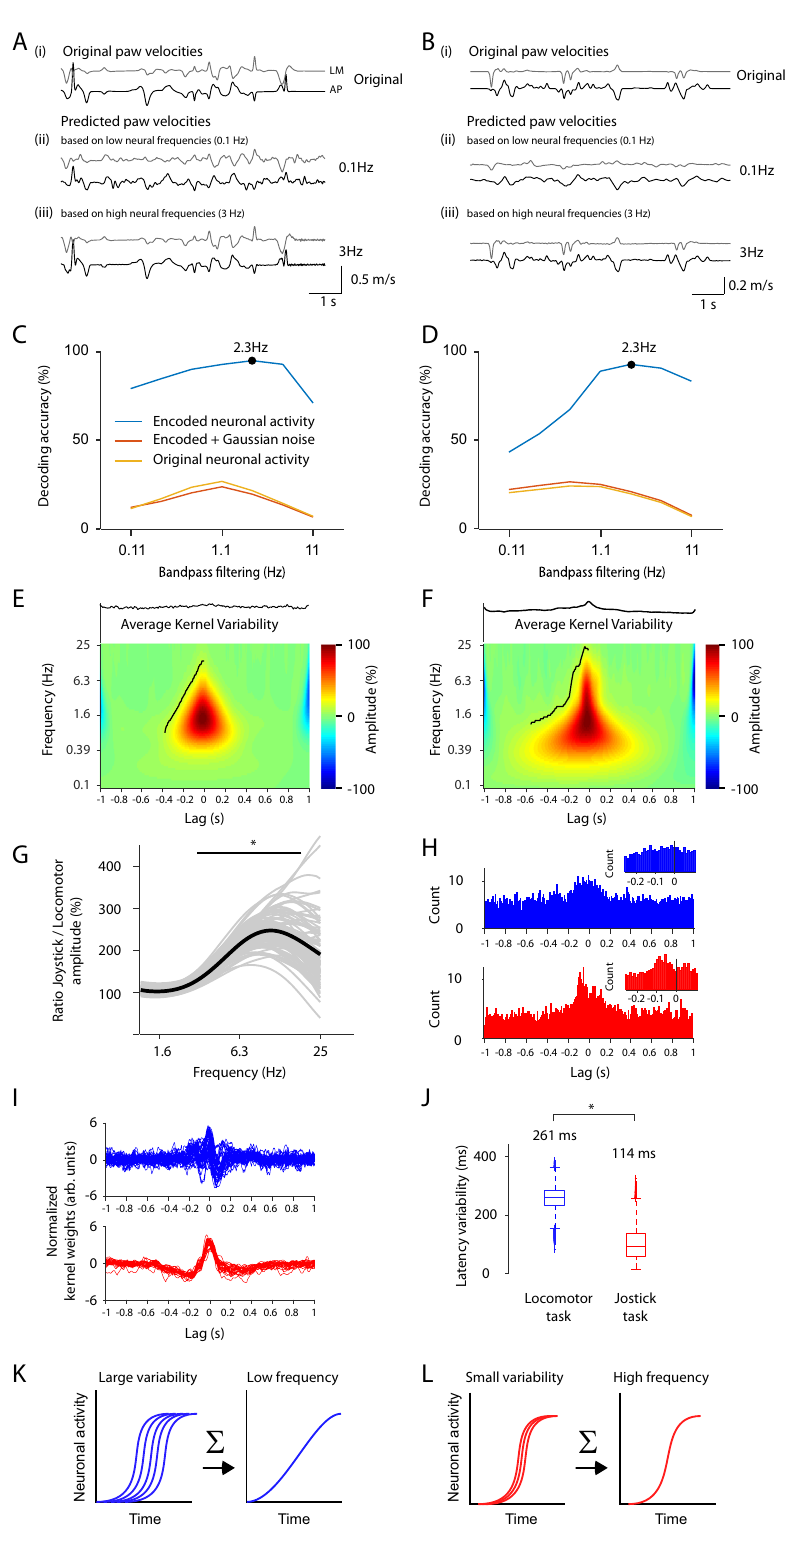
fi ve different frequencies 0.1, 0.3, 1, 3, and 10 Hz. To minimize resulted in an overt cyclic paw movement (see Fig. 7C, D, Sup- the effect of harmonics, the light was varied according to a plementary Movie 1; the average number of behavioral cyclic paw sinusoidal function. To test whether slow oscillations induced a movements for 3 Hz stimulation was 2.3 ± 0.5 Hz, and for 10 Hz depolarization block, we measured extracellular activity in close stimulation was 3.4 ± 1.4 Hz.) This movement threshold between 1 and 3 Hz aligns with the following: (1) The movement gen- proximity to the optical fi ber (Fig. 7A, B). All stimulation fre- quencies resulted in strong increases in neuronal fi ring. However, eration was associated with a time constant of 400 ms (Fig. 3J) in line with our high-frequency hypothesis, only 3 and 10 Hz (corresponding to 2.5 Hz), and (2) the peak in the correlation NATURE COMMUNICATIONS| (2021) 12:5390